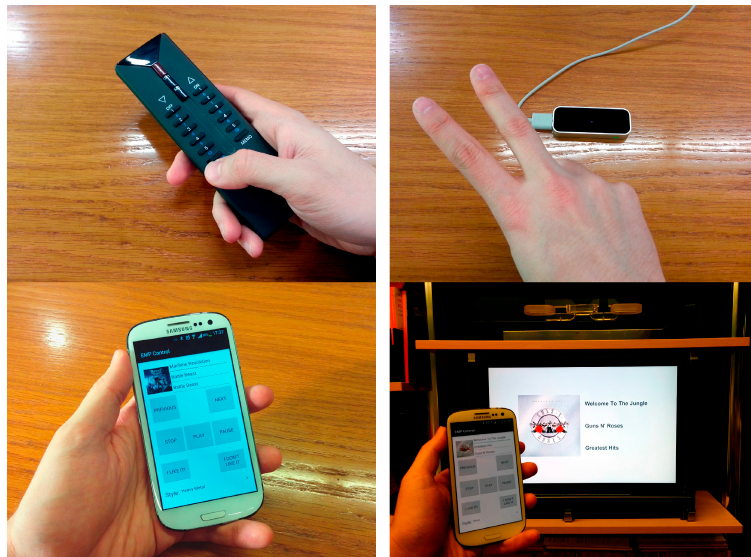
Figure 7. Four of the FIOs used for the selection of music style in the EMP example. First, a KNX home automation remote controller using buttons to select the style. Second, a Leap Motion device for finger and hand gesture recognition. Third, a custom Android GUI application. Fourth, a TV display for output with a Kinect camera for input of the style with gestures.